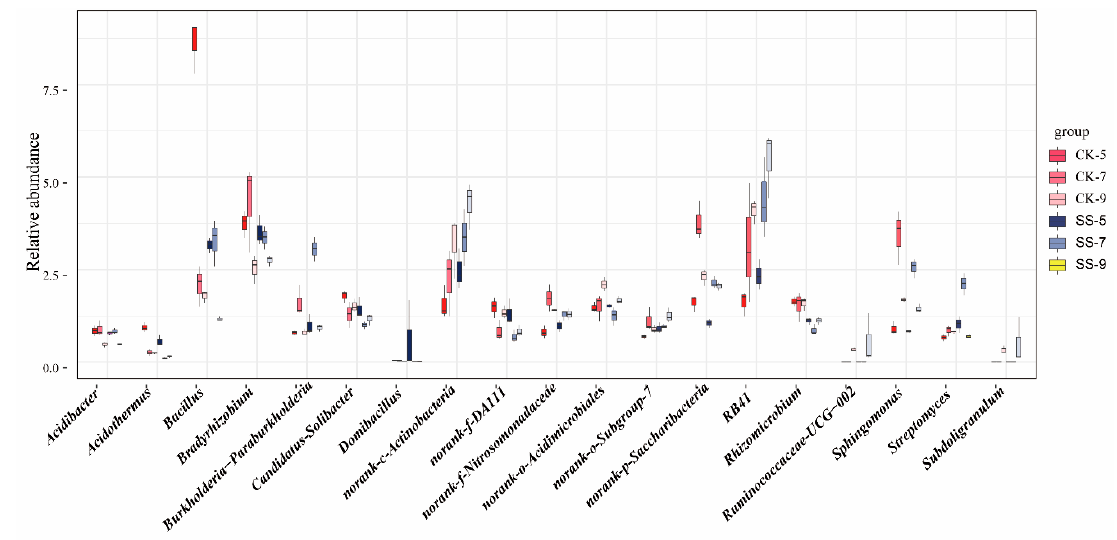
Figure 5. Comparative analysis showing the relative abundance of genera levels of CK-5, CK-7, CK-9, SS-5, SS-7, and SS-9.